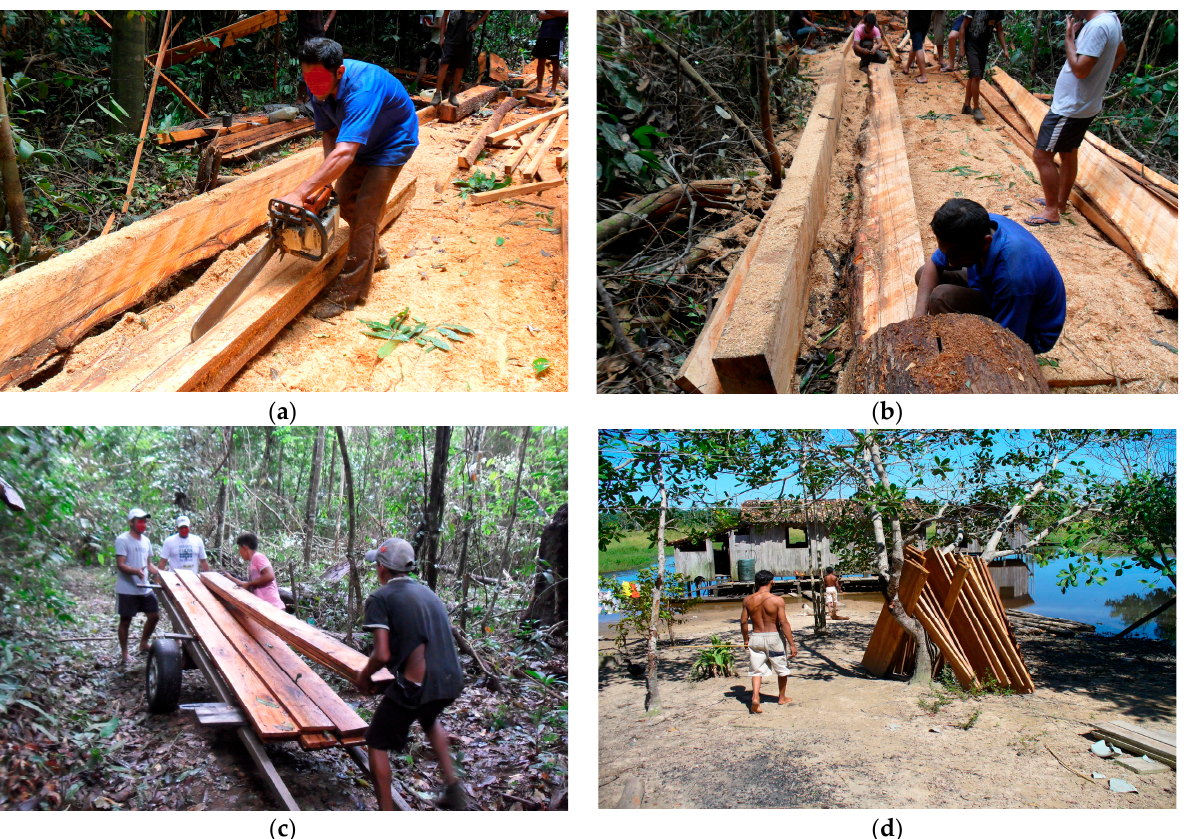
Figure 4. Main practices for timber extraction used by families in Porto de Moz. ( a ) Felling of trees with a chainsaw after the area and trees of interest are selected. ( b ) Timber saw by extractive workers using a chainsaw. ( c ) Wheels used by families to transport sawn timber through the forest up to the river margin. ( d ) The wood acquired by families is used for constructions of houses, boats, and stilt corrals, and for trade in local markets.